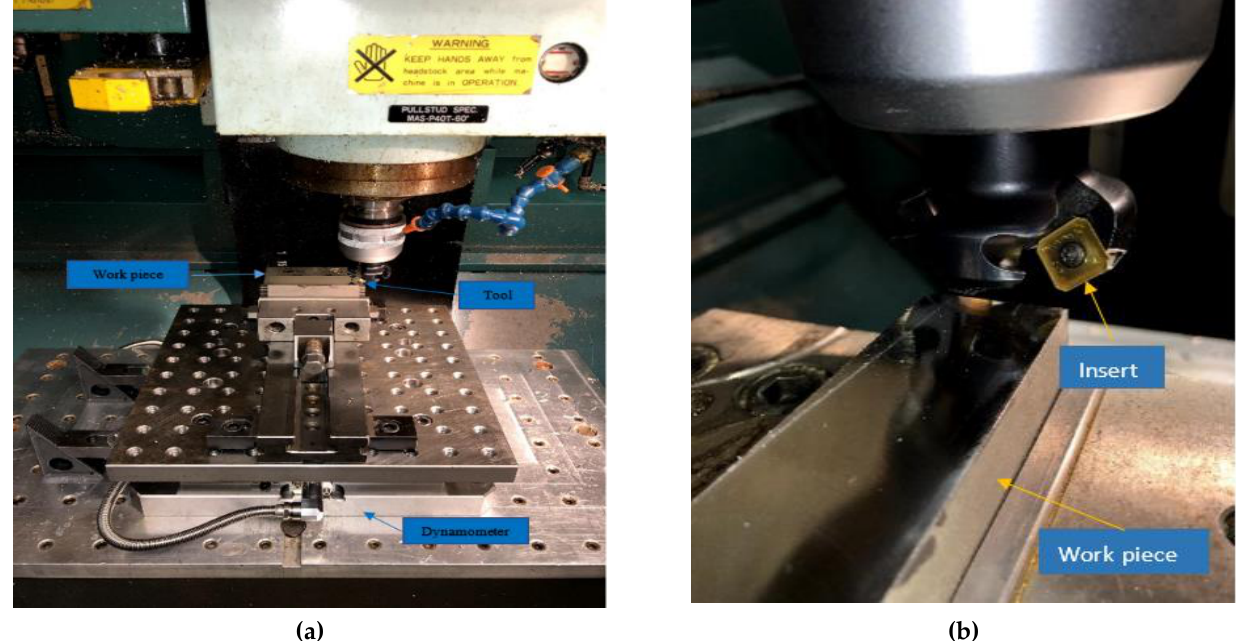
Figure 1. ( a ) Milling experimental setup and ( b ) the insert. Table 1. Elemental composition of Ti-MMC [32].